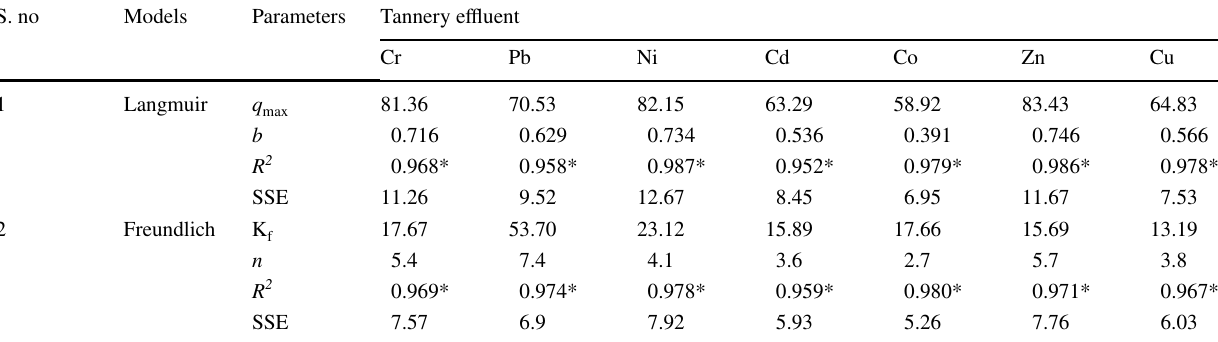
Table 5 Isotherm models of Langmuir and Freundlich constant biosorption kinetics for Chlorella